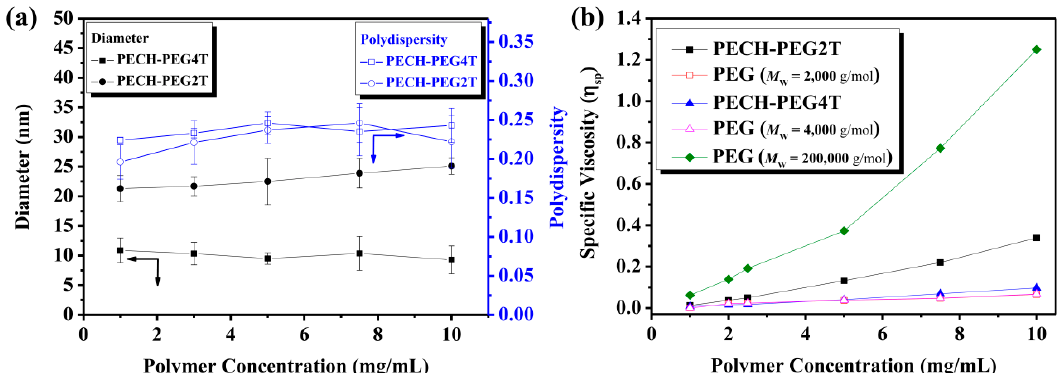
Figure 2. ( a ) Mean hydrodynamic diameter and polydispersity index of various concentrations of PECH ‐ PEG4T and PECH ‐ PEG2T in water. ( b ) Specific viscosity of various concentrations of of PECH-PEG4T and PECH-PEG2T in water. ( b ) Specific viscosity of various concentrations of PECH ‐ PEG4T, PECH ‐ PEG2T and commercial PEG polymers in water. PECH-PEG4T, PECH-PEG2T and commercial PEG polymers in